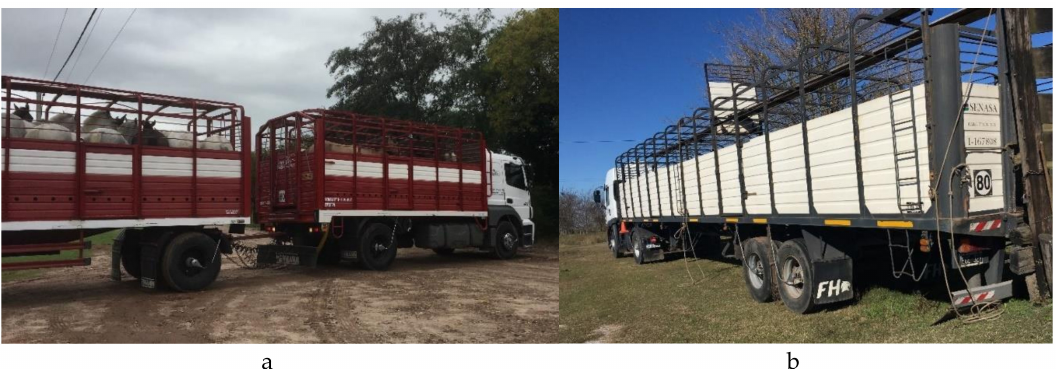
Figure 1. Example of di ff erent transport combinations. ( a ) A truck–trailer: a truck pulling a trailer and ( b ) A tractor–trailer: a pulling vehicle (without loading space) hauling a trailer through a fifth-wheel